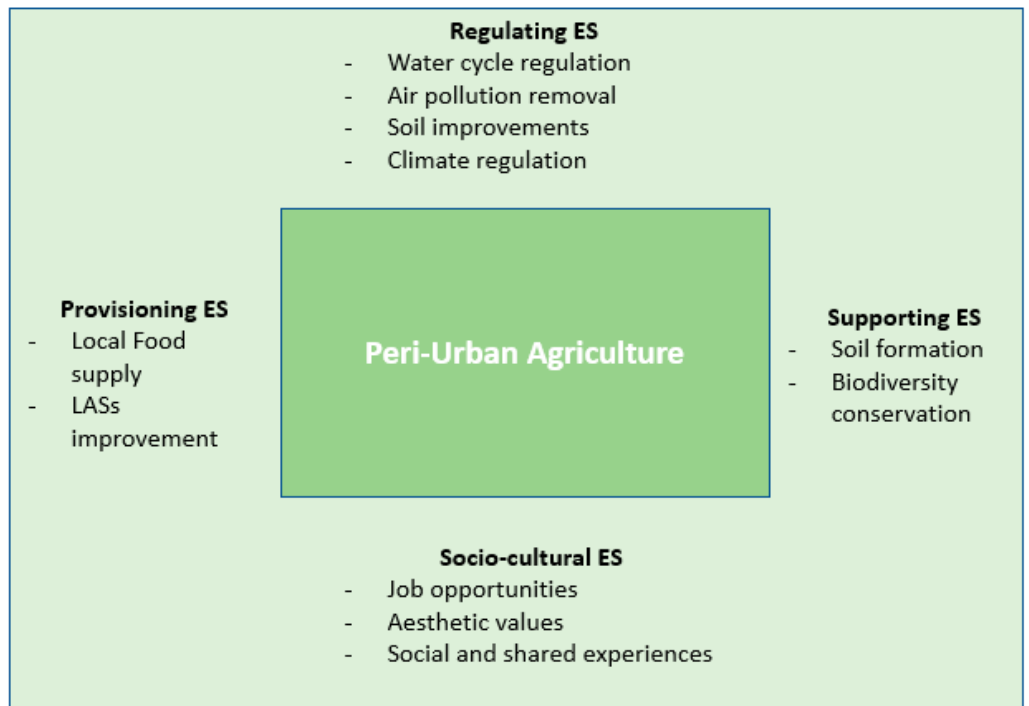
Figure 1. The wide range of Ecosystem services granted by peri ‐ urban agriculture.